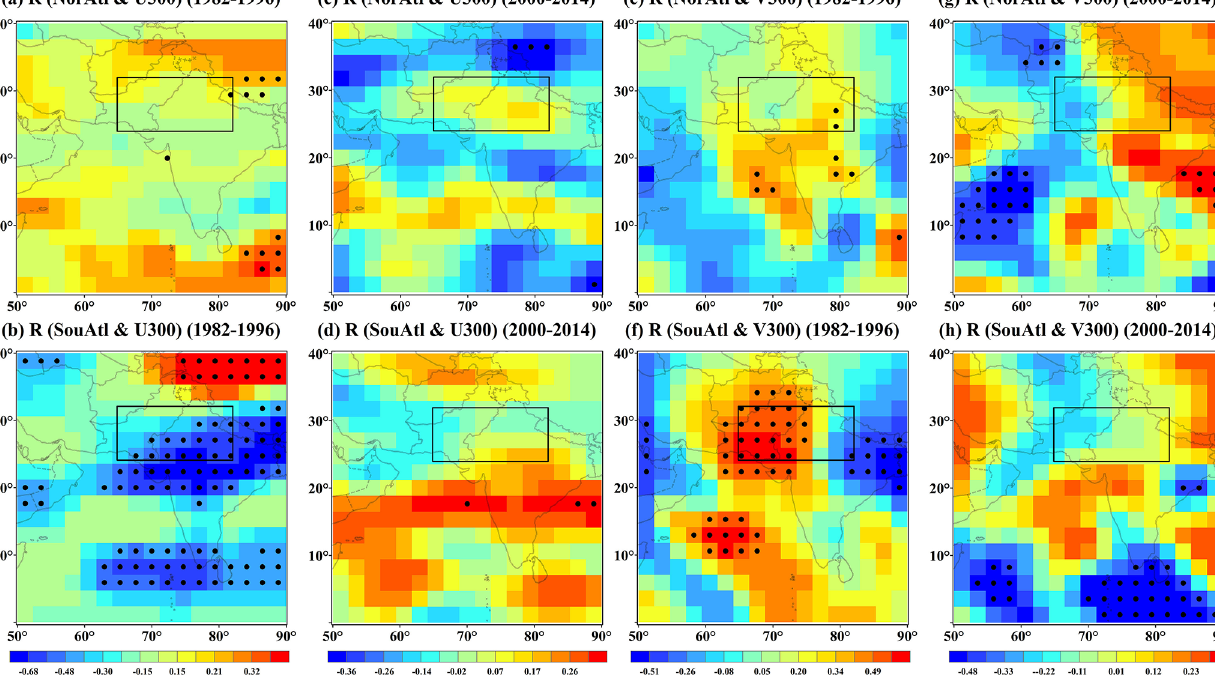
Figure 7. Correlation between the spring (March–May) tropical North and South Atlantic SSTA (NorAtl/SouAtl) with the ENSO signal removed and zonal wind ( U ) (a–d) as well as meridional wind ( V ) (e–h) at 300hPa in the dust season (June–July). (Correlations that passed the 90% confidence level were marked by black